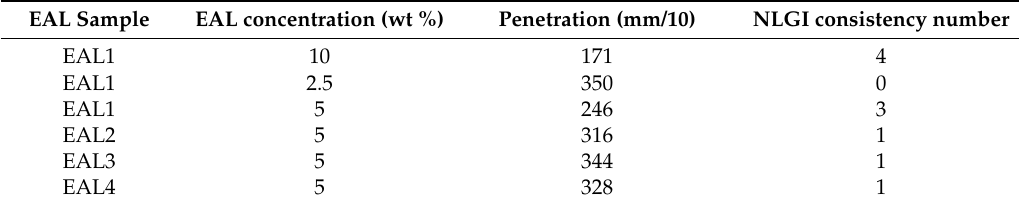
Table 3. Unworked penetration values and NLGI grade (ASTM D217) for EAL-based oleogels.